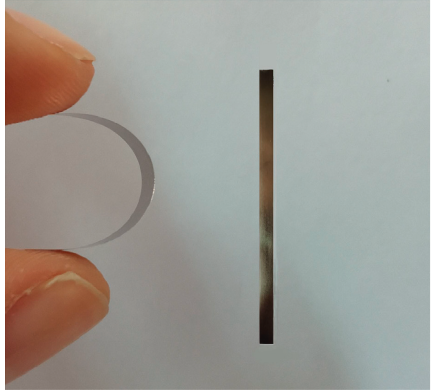
Figure 1: The appearance and flexibility of